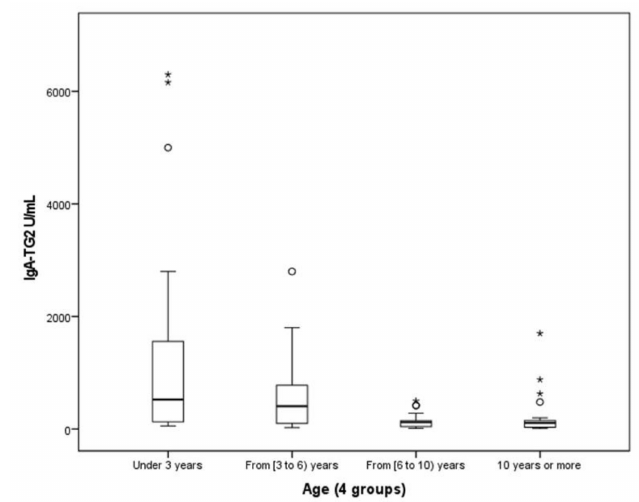
Figure 3. Relationship between age and IgA-TG2. Abbreviations: IgA-TG2, IgA antibodies against tissue transglutaminase Type 2. ◦ , Outliers are values between IORs and three IORs from the end of a box. * Values more than three IORs from the end of a box.